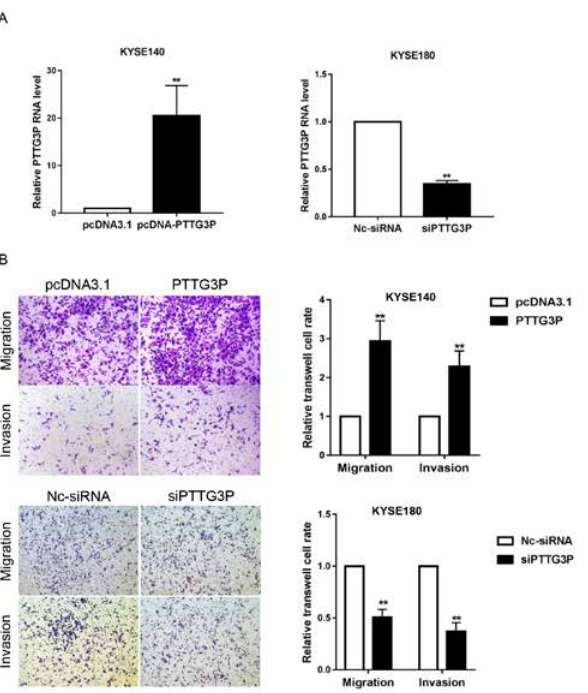
shown as the mean ± SD of three replicates. ** P<0.01.